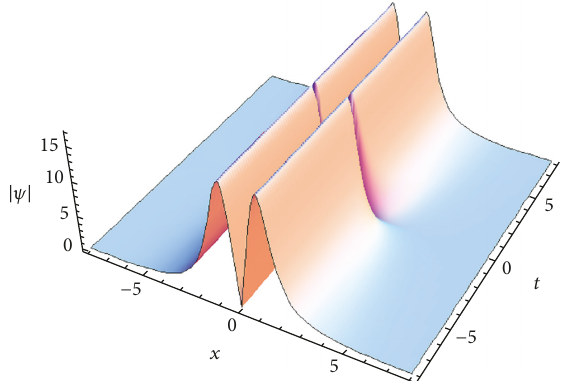
Figure 3: Spatial structure of the module of solution (20) with 𝑞 0 = 100 .